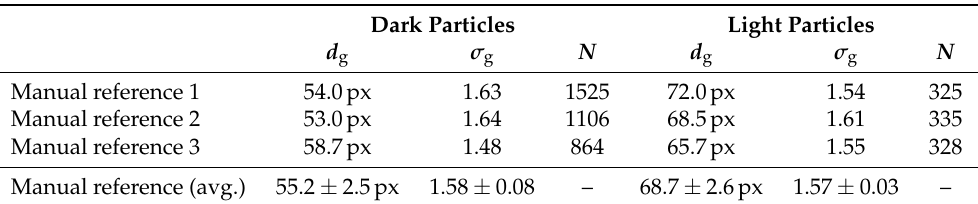
Figure 3. Comparisons of particle size distributions resulting from manual reference measurements, each for dark ( a ) and light ( b ) particles. Shaded areas represent ± σ . Table 1. Particle size distribution properties (geometric mean diameter d g , geometric standard deviation σ g , and number of particles N ) of dark and light populations of three manual references and averaged manual reference (mean ± standard deviation of d g and σ g ,